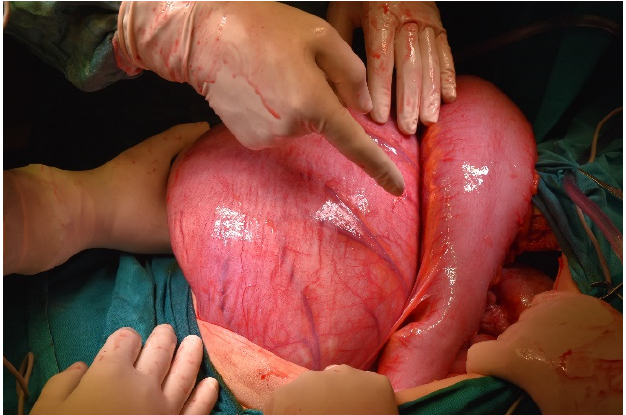
Figure 10. Intraoperative picture. Intrabdominal adhesions.